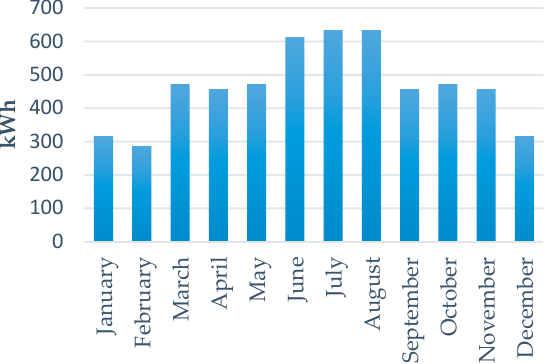
Figure 3. The synthesized electricity consumption of an average four-person household. The estimated baseload of the lowest 3 months was approximately 300 kWh.